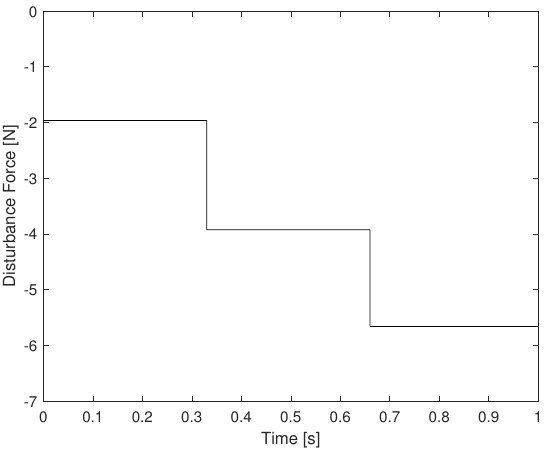
Figure 9. Profile of the disturbance force over time.